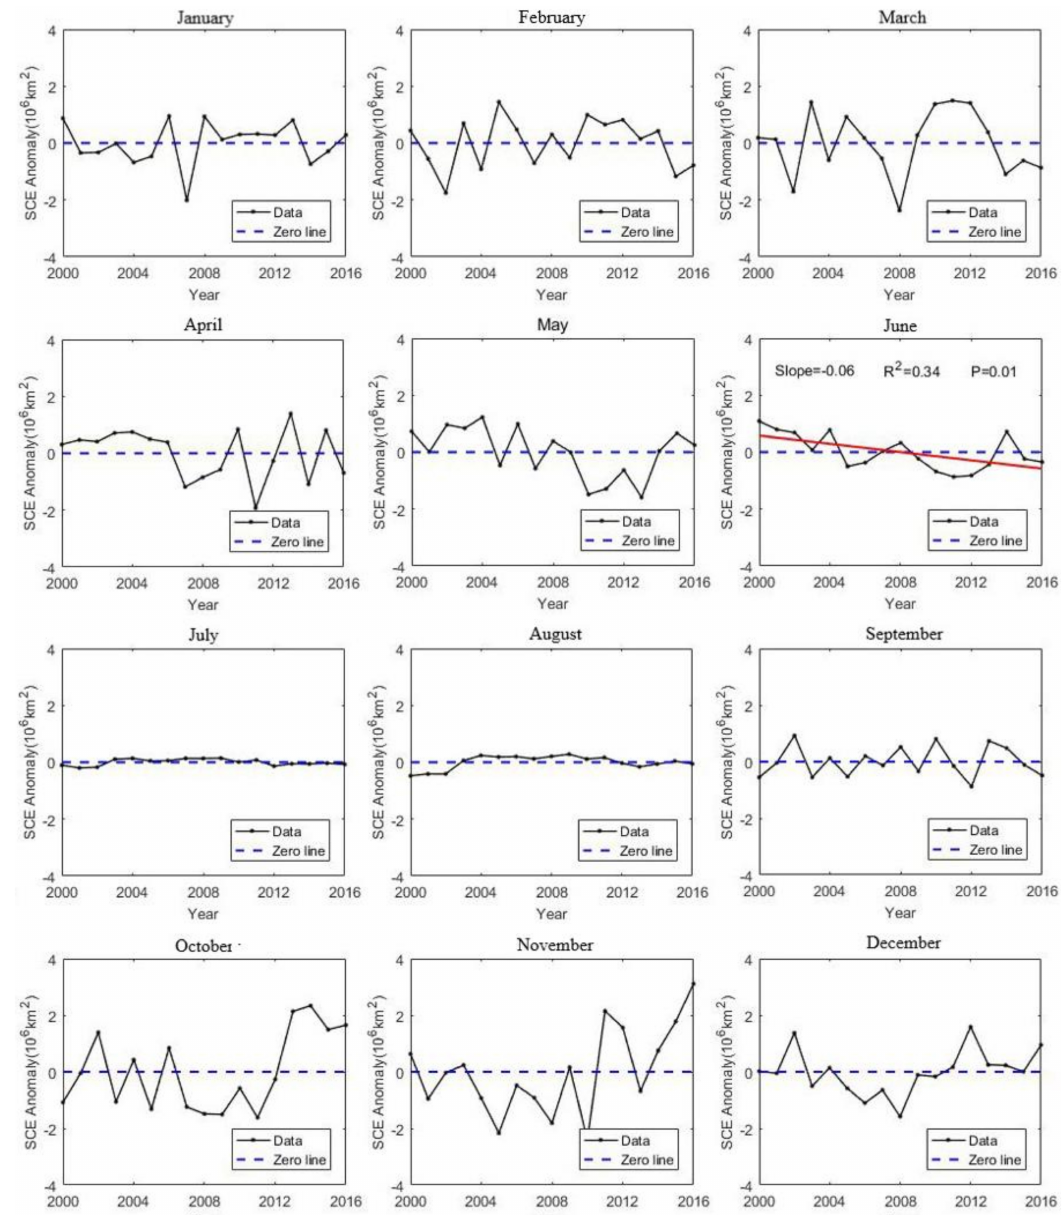
Figure 5. Monthly anomaly of average SCE in the study area from 2000 to 2016. The black line and blue line show the anomaly and zero values, respectively.